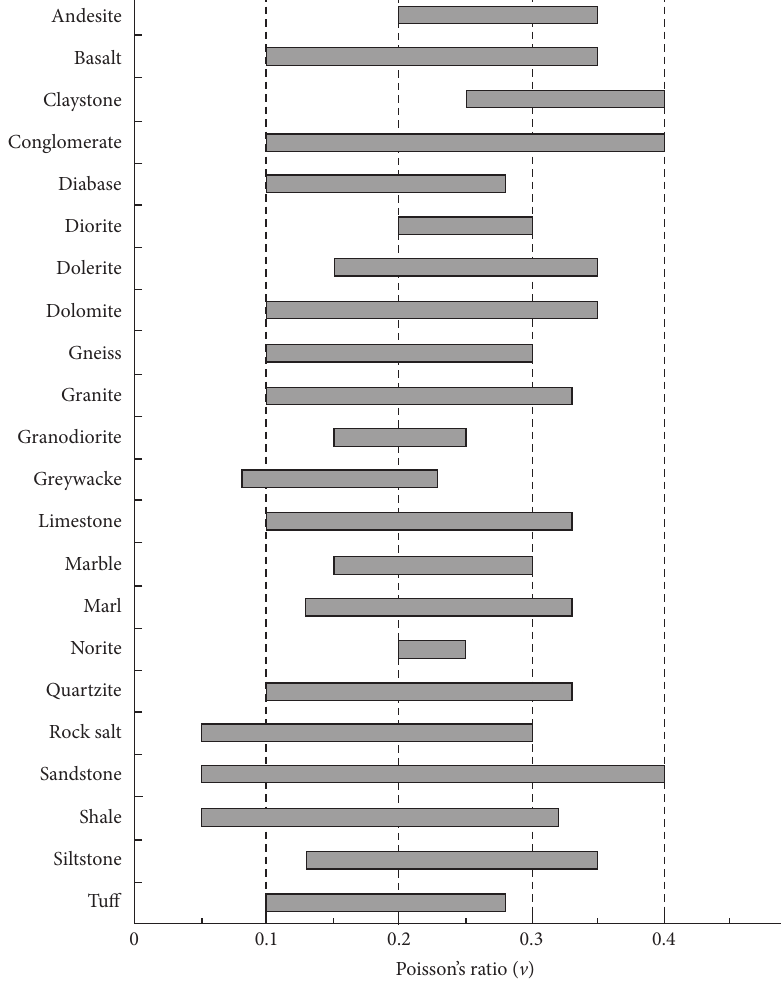
Figure 1: Distribution of Poisson’s ratios for typical types of rocks